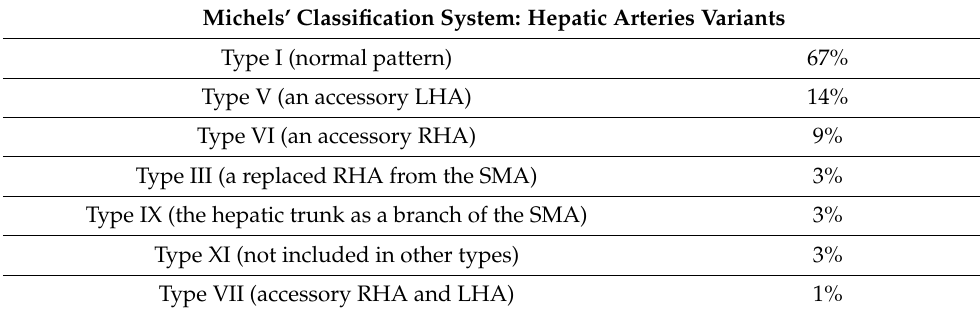
Table 4. Percentage of hepatic artery variants according to Michels’ classification system. Michels’ Classification System: Hepatic Arteries